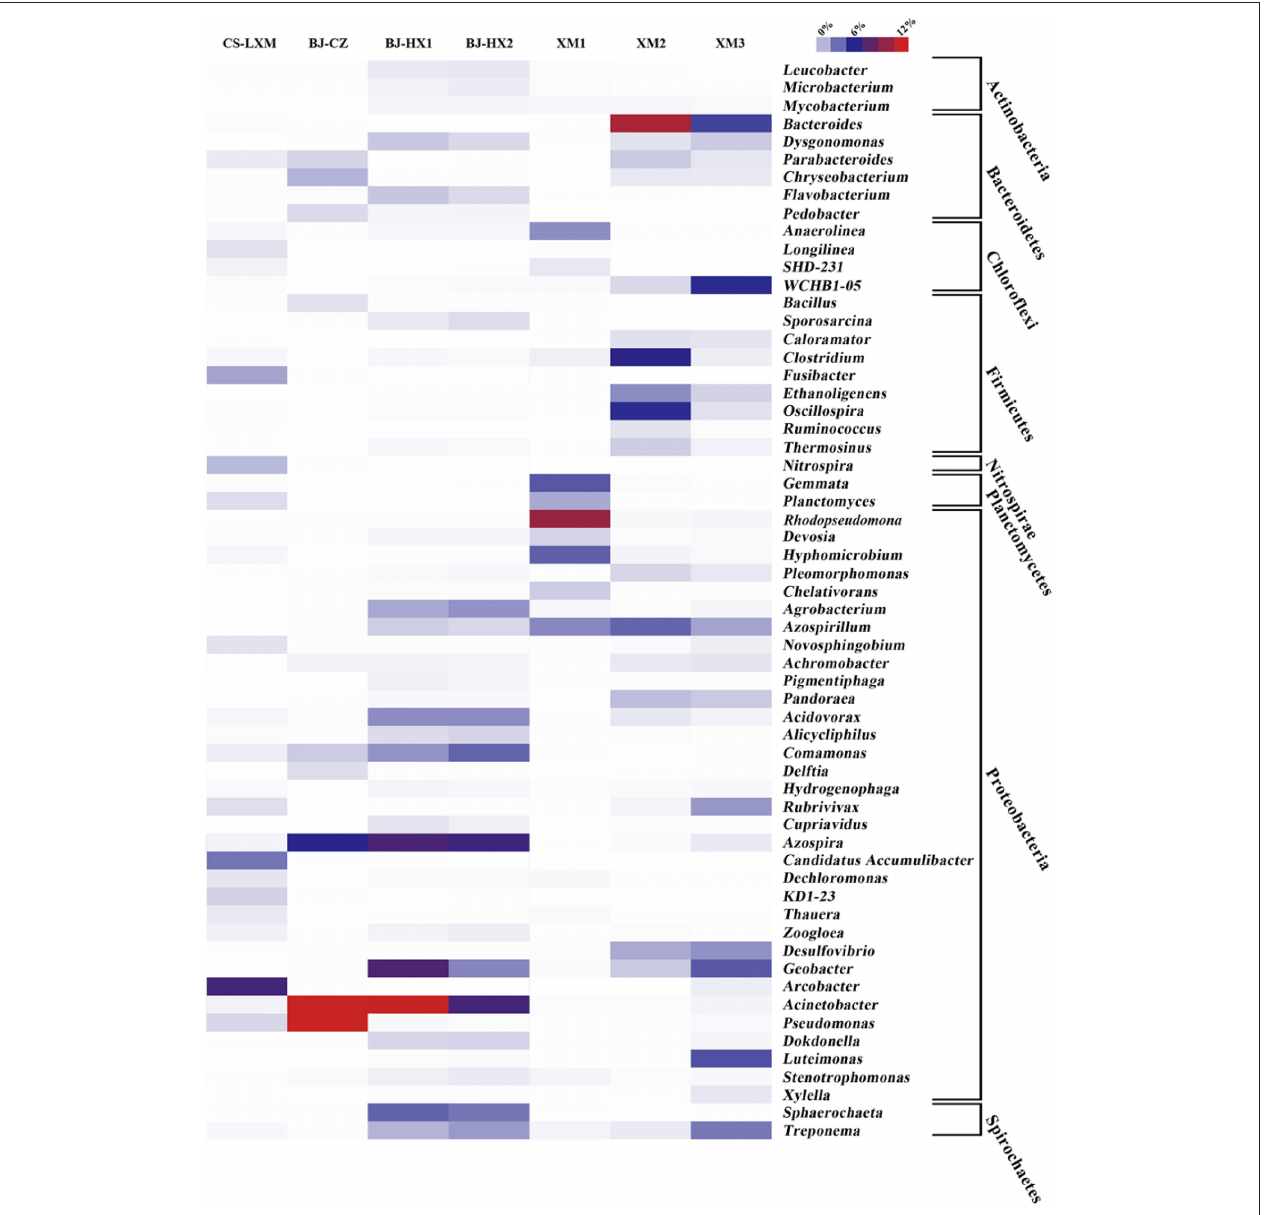
FIGURE 3 | Heat map of 60 genera whose average relative abundance in 7 EAB samples was higher than 0.1% (a total of > 0.71%). The color intensity in each panel shows the relative abundance (in percentage) of a genus in a sample, referring to color key at the right